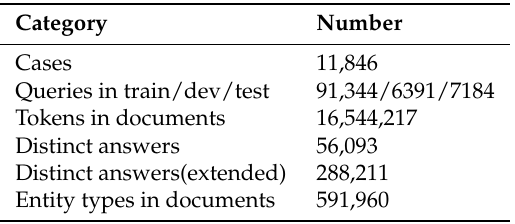
Table 1. The data set details for